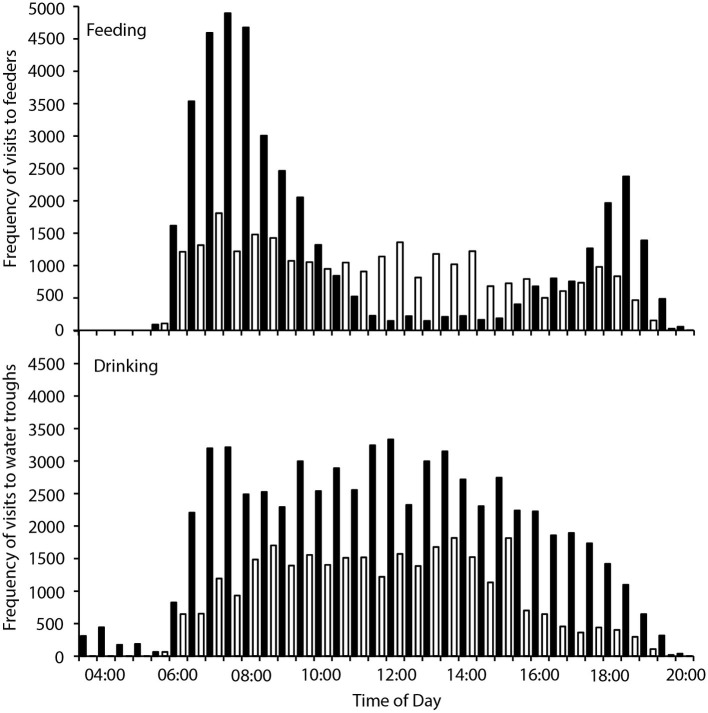
Frequency of visits to four feeders (top panel) and two water tanks (bottom panel) by zebra finches (Taeniopygia guttata) in an arid habitat during hot periods (maximum daily Ta > 40°C; black bars) and cool periods (maximum daily Ta < 30°C; white bars).